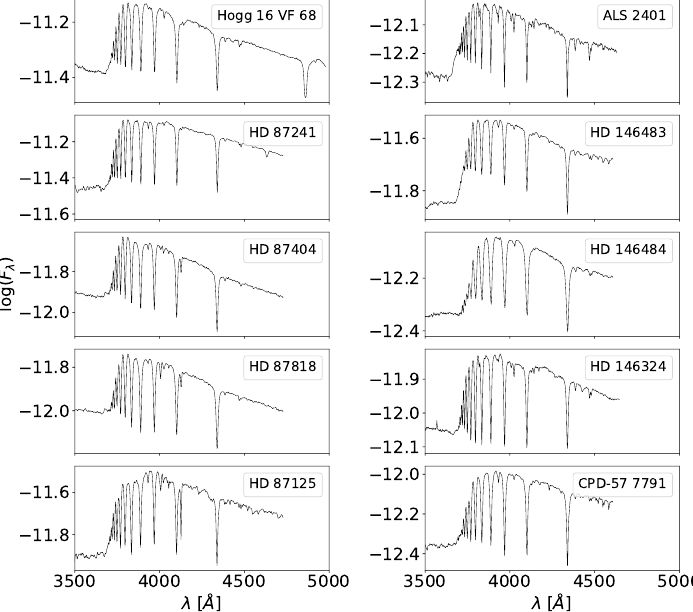
Figure 6. Low -resolution flux-calibrated spectra taken in CASLEO for Be stars in clusters with the scBD in absorption. Adapted from Aidelman et al. [144].